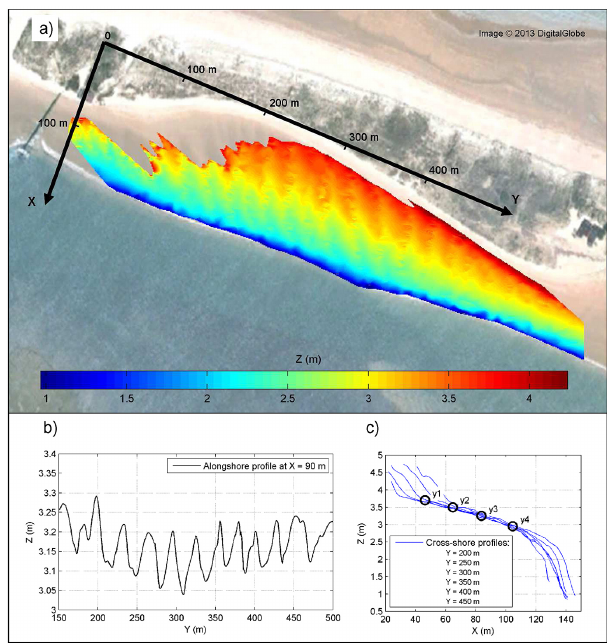
Figure 5. (a) Bathymetry reconstruction with videoed shoreline po- sitions during rising tide (24 June 2008). The north–west area with- out data is the shadowed area by the dune, from the point of view of the camera. (b) Alongshore profile of the bed level. (c) Cross-shore profiles of the bed level and cross-shore positions of the y 1– y 4 axes. Image from Google Earth, © 2013 DigitalGlobe.